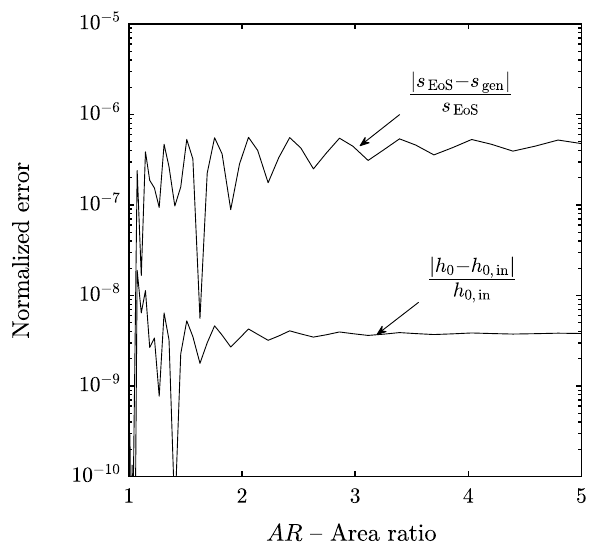
Figure 6. Enthalpy and entropy error analyses for the reference case defined in Table 3.